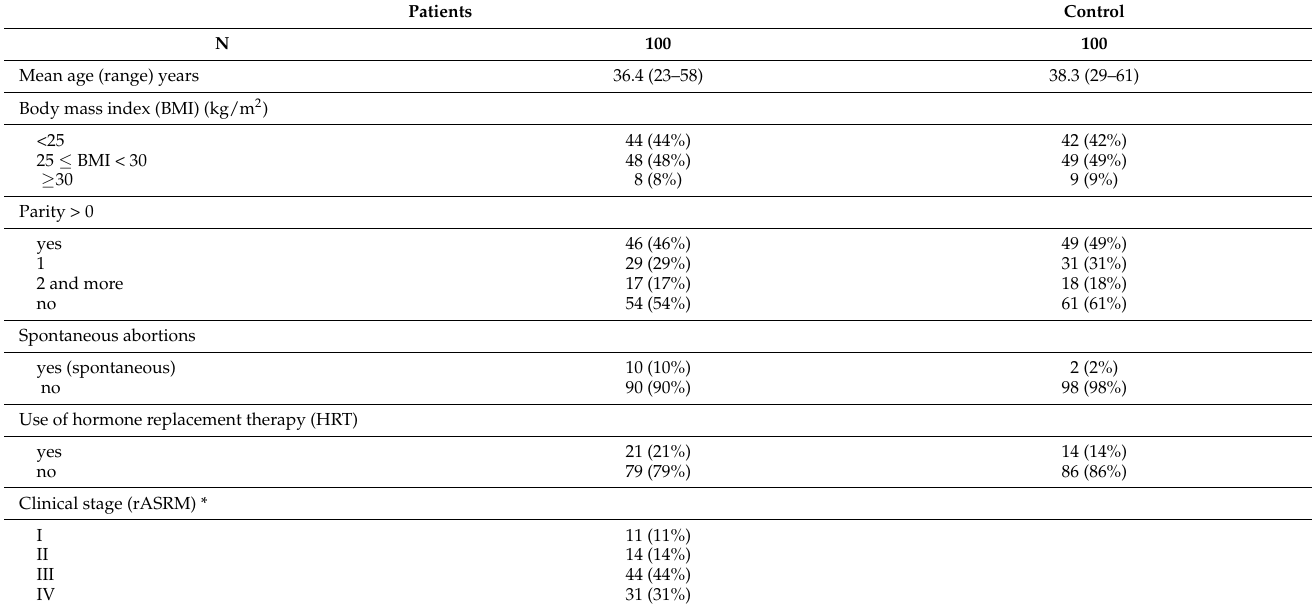
Table 1. Characteristics of patients with endometriosis and control